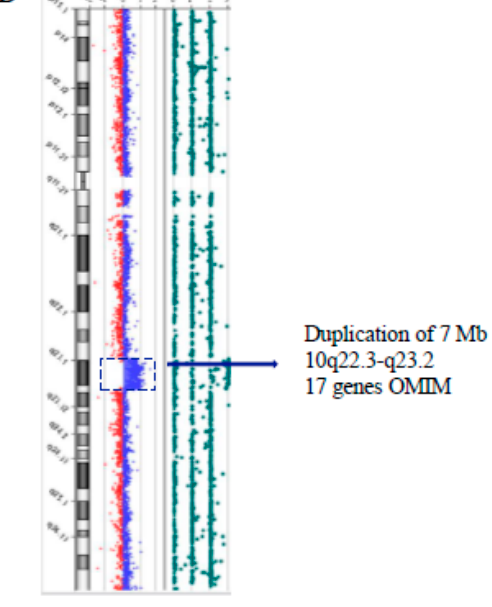
Figure 2. Array-CGH-SNP results. ( A ) The LCSH on chromosome 1p13.2-p11.2 is indicated by a black dashed rectangle. This region of 8.36 Mb containing 58 OMIM genes among which HSD3B2 . ( B ) Duplication of 7 Mb,10q22.3-q23.2 (81,641,918_88,717,407)x3 which contains 17 OMIM genes. The aCGH-SNP disclosed two long, continuous stretch of homozygosity (LCSH), one of 8.36 Mb (from rs2488762 to rs1853728) on chromosome 1p13.2-p11.2 containing 58 OMIM genes and the other of 7.27 Mb (from rs12435615 to rs11845372) on chromosome 14q31.1-q32.11 containing 12 OMIM genes (Figure 2). Among the genes included in these two LCSHs, the best candidate to explain the clinical characteristics of II-3 was HSD3B2 , whose biallelic mutations have been previously detected in patients with 3- β -hydroxys- teroid dehydrogenase 2 deficiency. In order to identify pathogenic variants in this gene, and eventually in other genes related to the disorder, a clinical-exome sequencing (CES) was performed. The average sequencing depth was 64x with 97.43% of the target sequence covered at ≥ 20x, 91.74% covered at ≥ 50x and 73.61% covered at ≥ 100x. The variants were filtered as described and according to the ACMG guidelines. The two LCSH regions were con- firmed by the CES, and a pathogenic homozygous variant on 1p13.2-p11.2 was detected in the exon 4 of HSD3B2 , namely c.969T > G (Figure3B). This missense variant converts codon 323 (AAT), which codes for Asparagine at highly conserved position, into AAG, encoding Lysine (p.Asn323Lys). The variant was not present in public databases (ExAC, dbSNP, ESP, gnomAD and the 1000 Genomes Project) and was classified as pathogenic according to the American College of Medical Genetics and Genomics (ACMG) guidelines for the interpretation of variations (criteria: PM2, PP1 Very Strong). No other clinically relevant variation was detected in other genes compatible with the patient’s clinical phe- notype and, consequently, p.Asn323Lys in HSD3B2 was the best disease-causing candi- date variant.